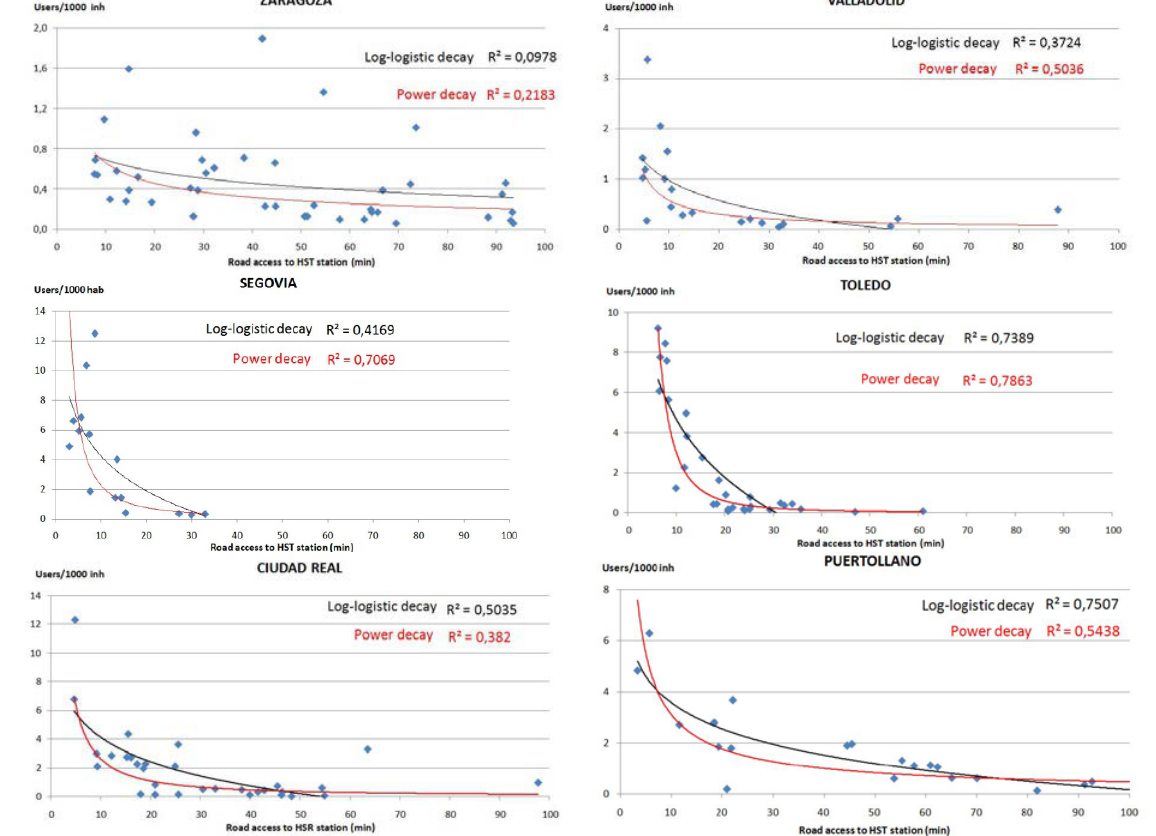
Figure 4. Ridership’s decay functions for HSR